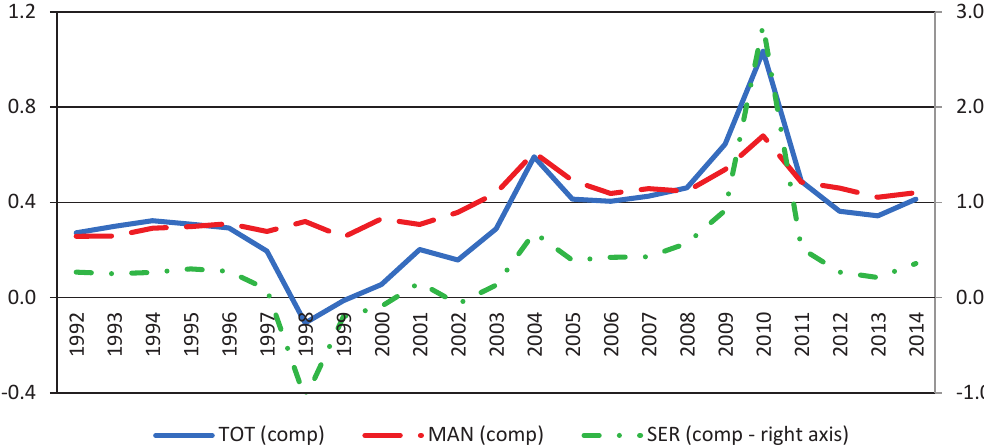
Figure 5 Contribution of the OP term to aggregate wage changes and net of changes in workers’ composition.